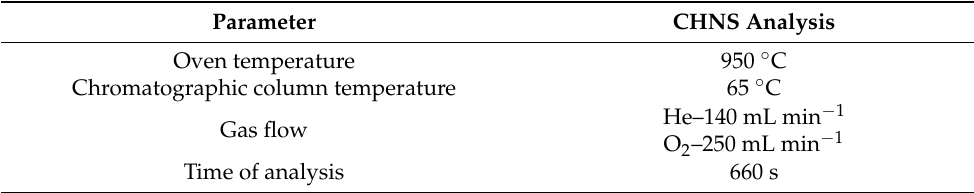
Table 1. Parameters of the elemental